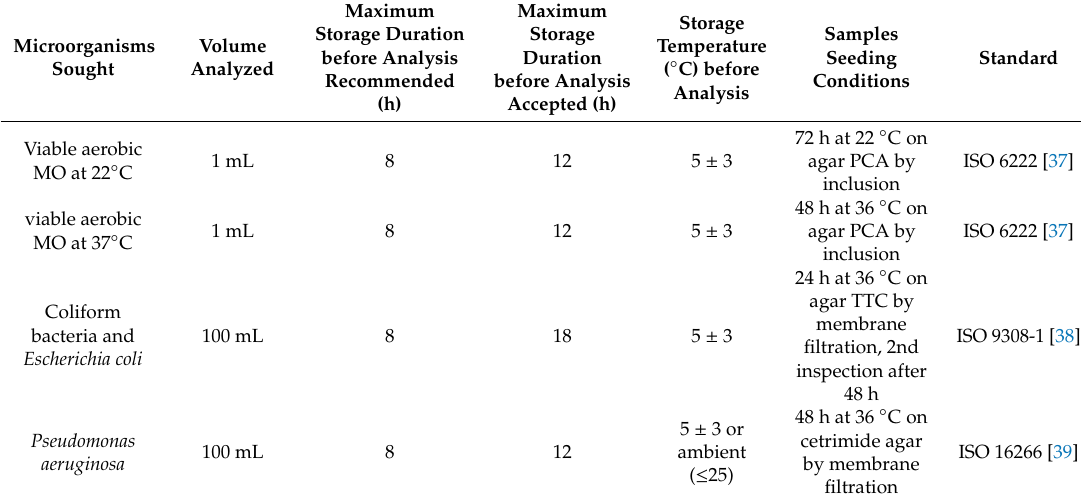
Table 1. Culture conditions of the output water samples collected from the MDDS and standards used [36].